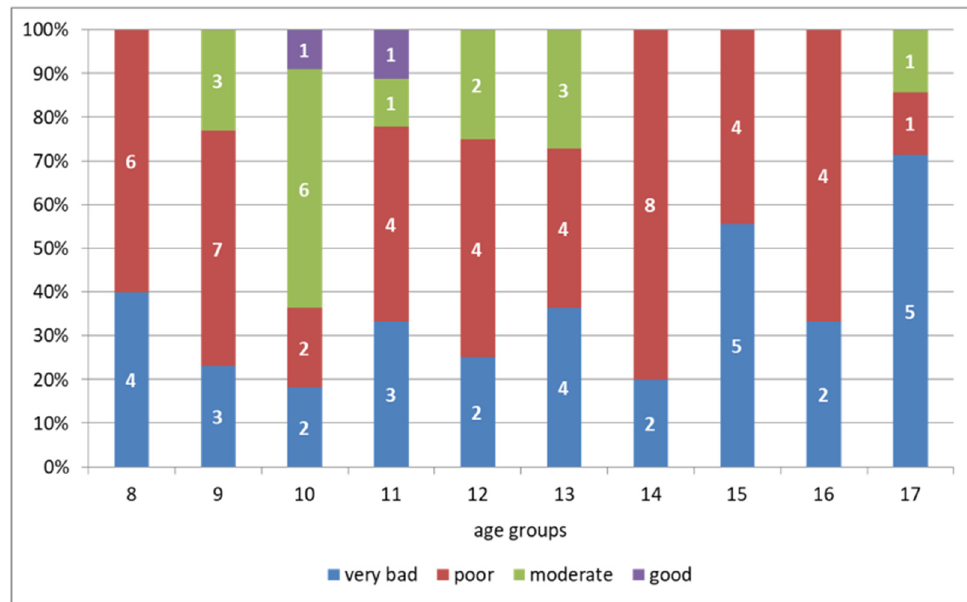
Figure 2. Ruffier test results according to reference data of Polish children aged 8–17 years with type 1 diabetes [25].